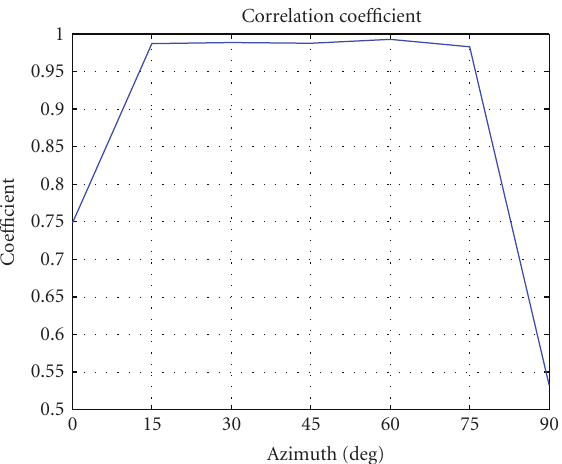
F 4: e correlation coefficients of the SAR images of the SLICY-like target in free space and above a rough surface at 7 azimuth directions.